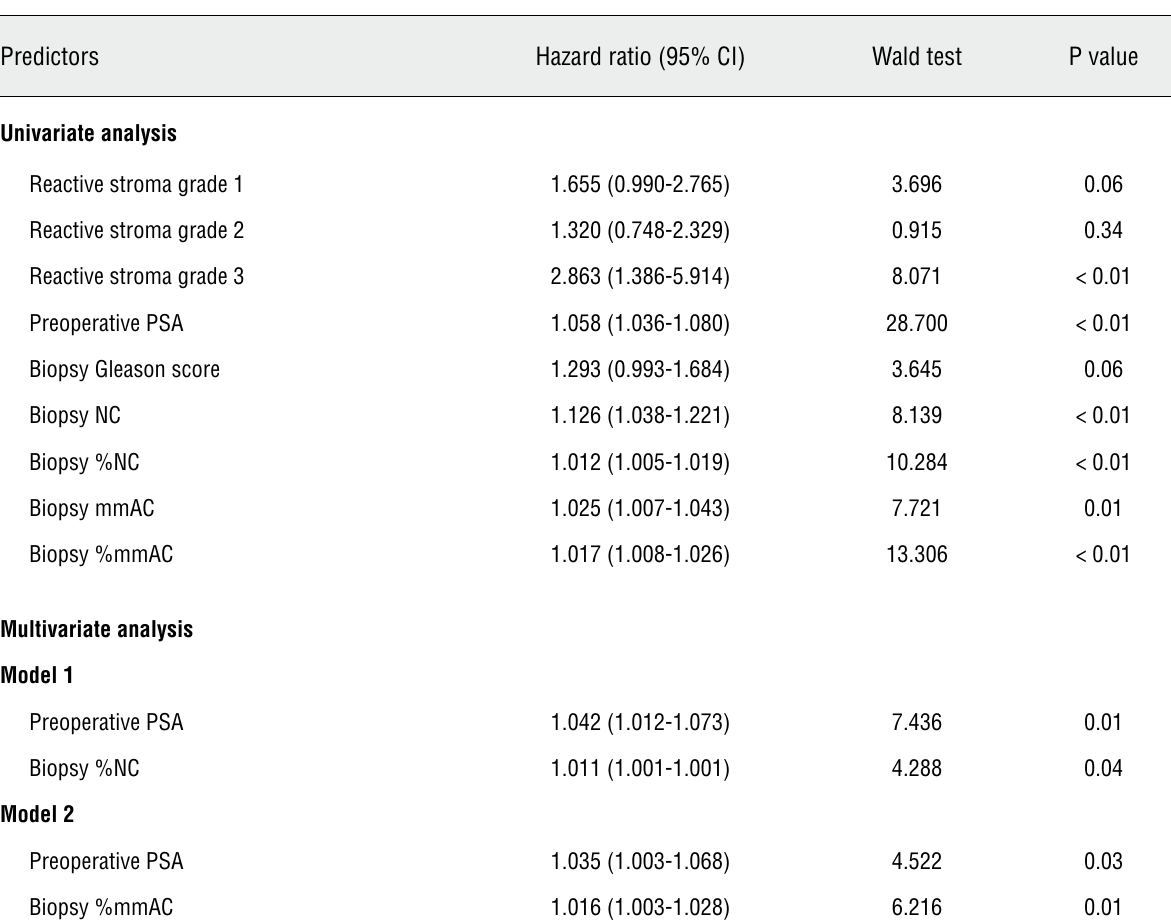
Table 2 - Cox proportional hazard analysis of several clinicopathologic factors predicting time to biochemical recurrence following radical